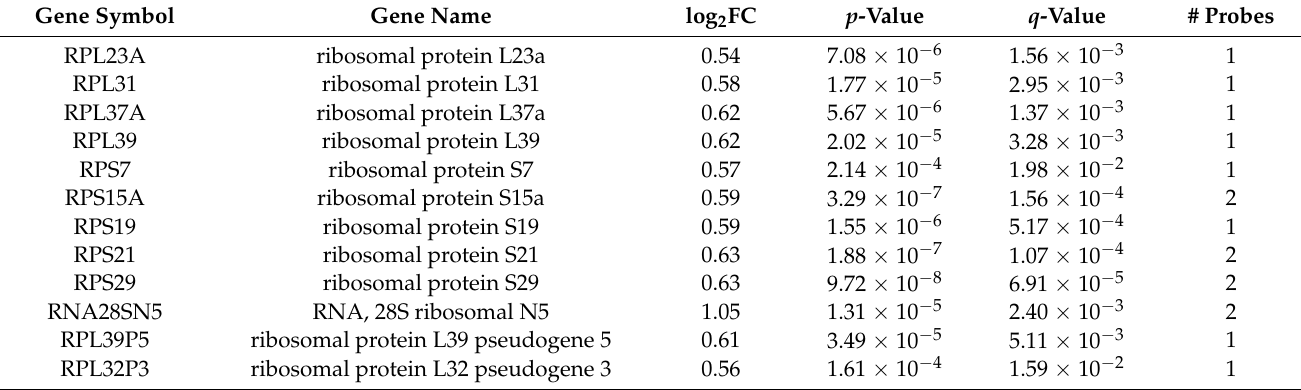
Figure 1. Differential gene expression results from the paired comparison between tumour and stromal samples. ( A ) For each patient (i.e., sample_1 to sample_6), the log 2 FC values of the 193 significant DEGs were heatmapped according to the red-blue colour scale shown in the upper-left corner. Positive log 2 FC values (blue hue) indicate overexpression in tumour compared to stromal samples. Both genes and samples were reordered using a distance-matrix-based hierarchical clustering approach (Euclidean measure and complete linkage), as shown by the dendrograms. ( B ) Volcano plot representing for each probe of the array the negative log 10 ( p -value) (as returned by the paired rank product test) plotted against the average log 2 FC. Horizontal dashed line is the significance threshold corresponding to a BH-FDR of 5%. Vertical dashed lines are the cut-offs on FCs (|log 2 FC| > 0.5). Red dots represent the 193 DEGs ultimately retained as significant, as reported in Supplementary Table S1. Table 3. List of the ribosomal protein genes upregulated in the tumour compartment compared to the stromal compartment. For multiple significant probes targeting the same gene (see # probes column), the higher log 2 FCs and the lower p -values are